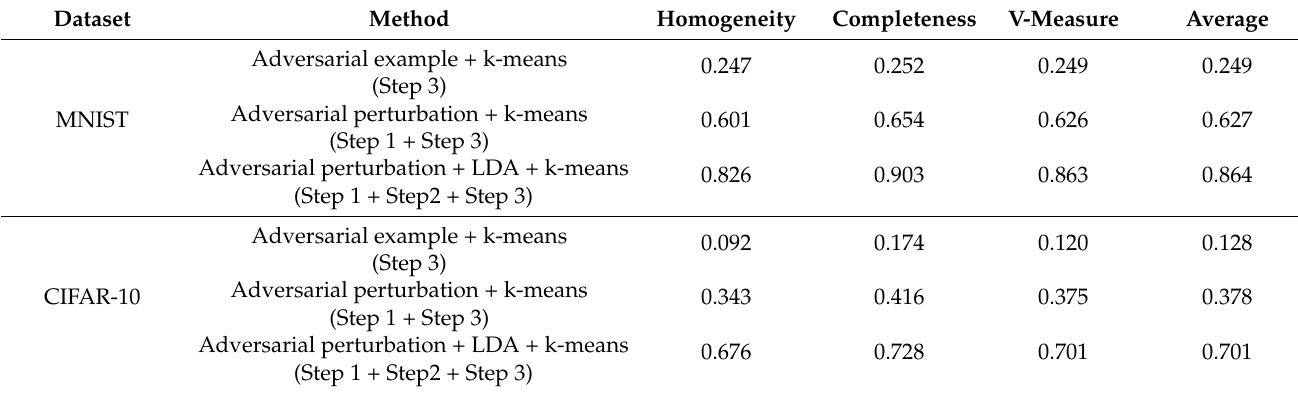
Table 2. Ablationanalysis results of the proposed